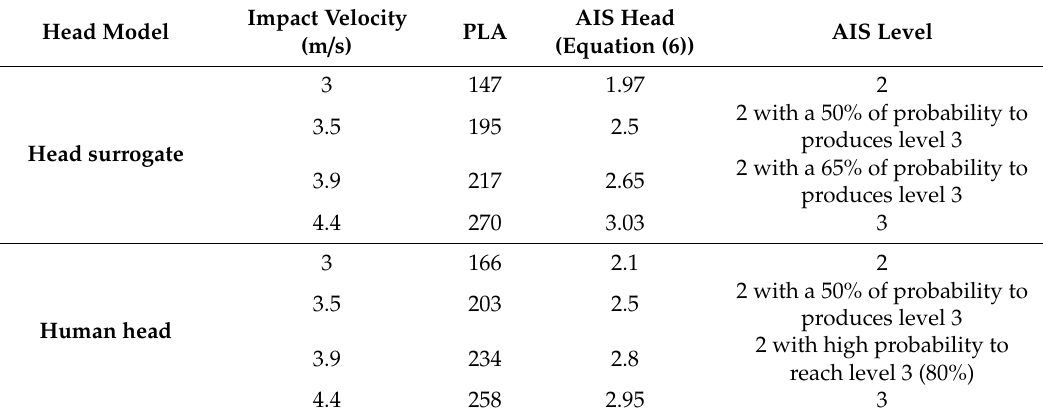
Table 10. PLA and AIS for impact velocity v 0 = 3 m /